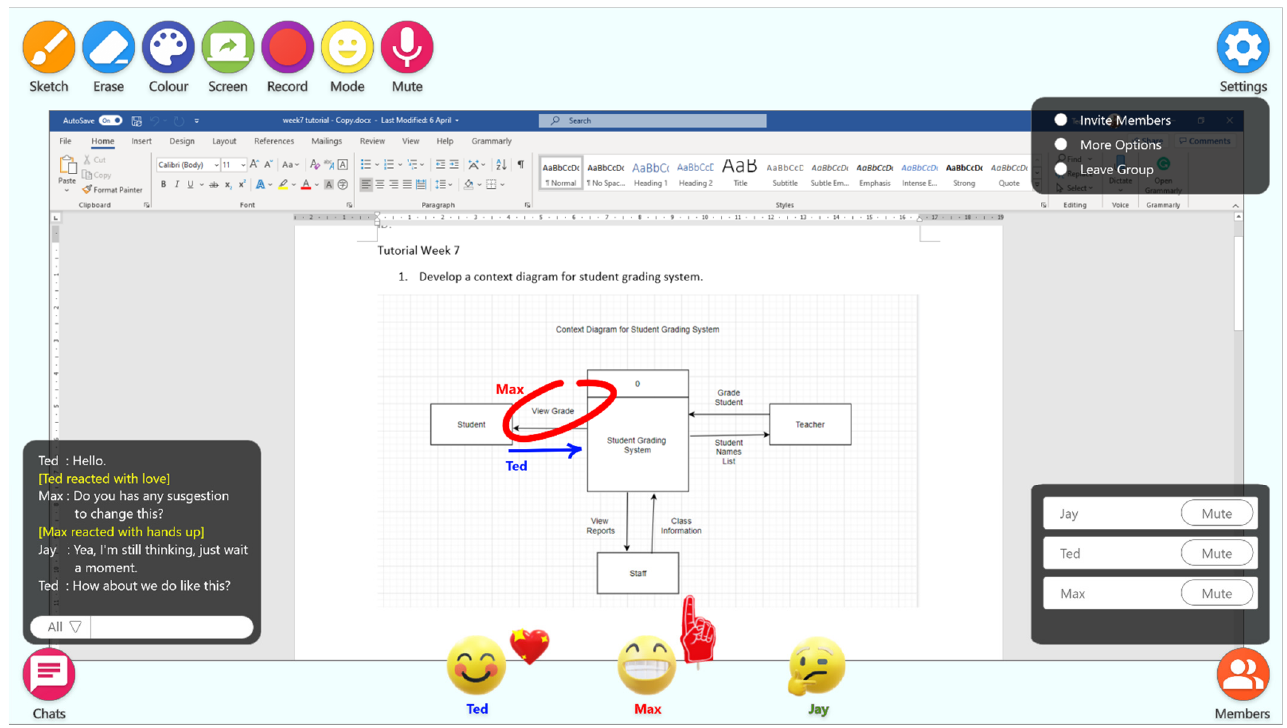
Figure 12. The user interface of the proposed virtual conference application for remote collaboration when users enter the group.